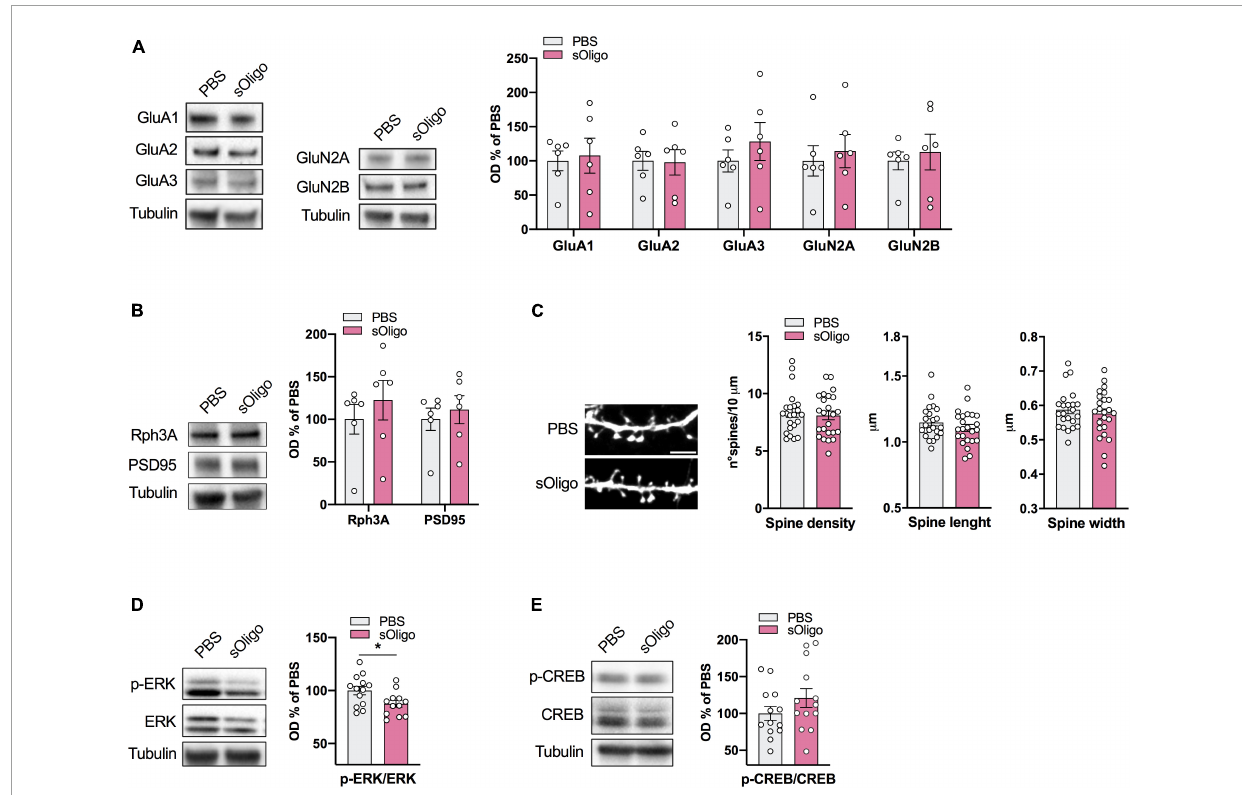
FIGURE4 Molecular effects induced by α syn sOligo at the hippocampal synapse in vitro . Primary cultures of rat hippocampal neurons were treated at DIV9 with either 2 µ g/ µ l sOligo or PBS and analyses were performed at DIV16. Post-synaptic levels of (A) AMPAR (GluA1, GluA2, and GluA3) and NMDAR (GluN2A and GluN2B) subunits and (B) the scaffolding protein Rph3A and PSD-95 were evaluated by Western blot in TIF from sOligo- or PBS-neurons. Protein levels normalized on tubulin were reported as OD% of PBS-neurons. n = 6 independent cultures. (C) Representative confocal images and quantification of spine morphology analyses (spine density, spine length and spine width) of sOligo- and PBS-neurons at DIV16. Scale bar: 3 µ m. n = 23–24 neurons from 3 independent cultures. (D) Levels of pERK were evaluated by Western blot in homogenates of sOligo- and PBS-neurons at DIV16. pERK level was normalized on total ERK expression and reported as OD% of PBS-neurons. n = 12–13 independent cultures. (E) Levels of pCREB were evaluated by Western blot in homogenates of sOligo- and PBS-neurons at DIV16. pCREB level was normalized on total CREB expression and reported as OD% of PBS-neurons. n = 14 independent cultures. Data are represented as mean ± SEM. * P < 0.05 (Student’s t -test; data with non-normal distribution were tested with Mann–Whitney